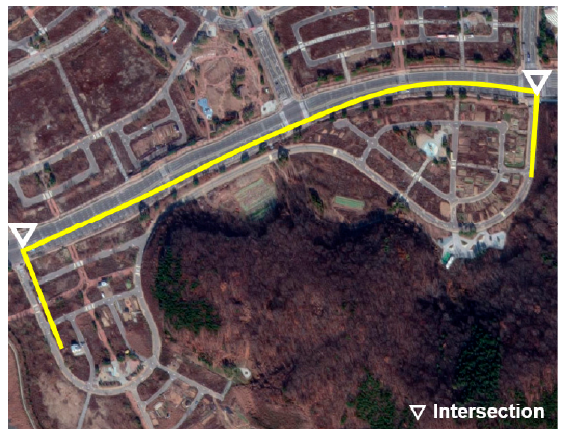
Figure 8. Test route for speed bump situations.